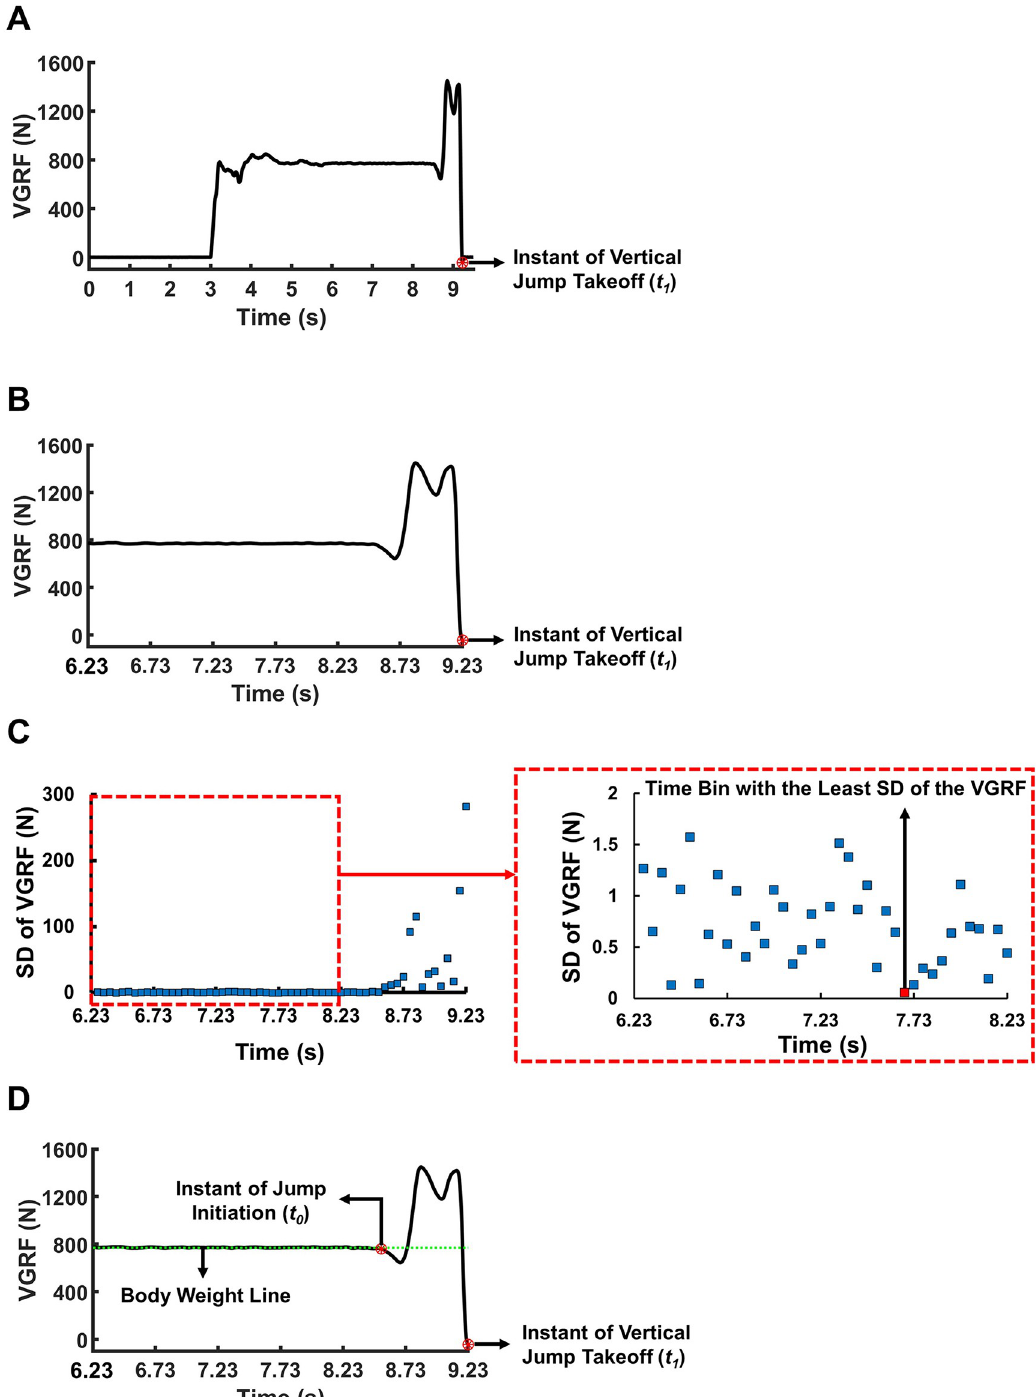
Fig 3. An illustration of the overall process of selecting the reference points for the calculation of vertical jump height (VJH) of a representative participant. (A) The time profile of the vertical ground reaction force (VGRF) during a single trial of the jumping task. The moment of vertical jump takeoff was defined as the moment when the VGRF value reached its minimum ( t 1 ) (denoted by a red star inside a red circle). (B) The section of the VGRF time profile that started at 3 s before t section was used to calculate the body weight (BW) of the participants. (C) The standard deviation (SD) of the VGRF. The VGRF section in (B) was divided into time bins of 50 ms (denoted by blue squares). The SD of the VGRF during each time bin